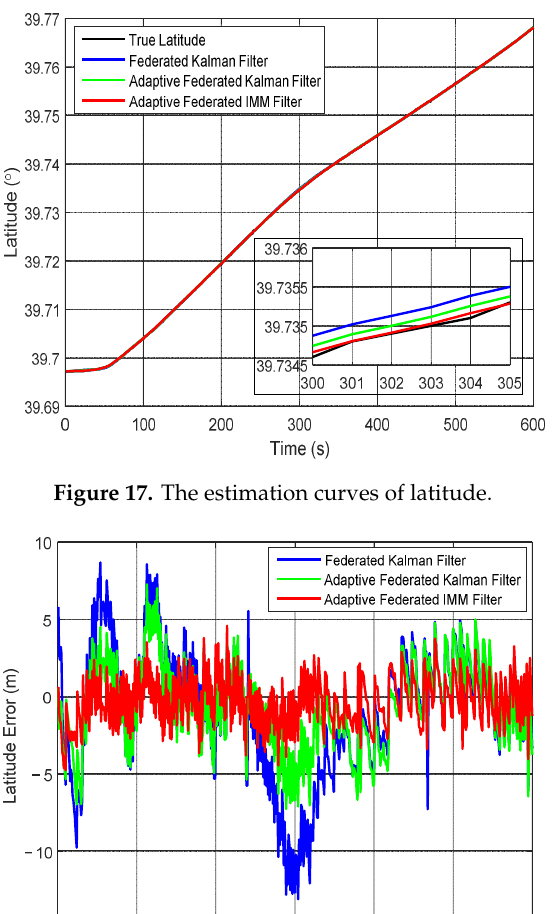
Figure 19. The estimation curves of longitude.